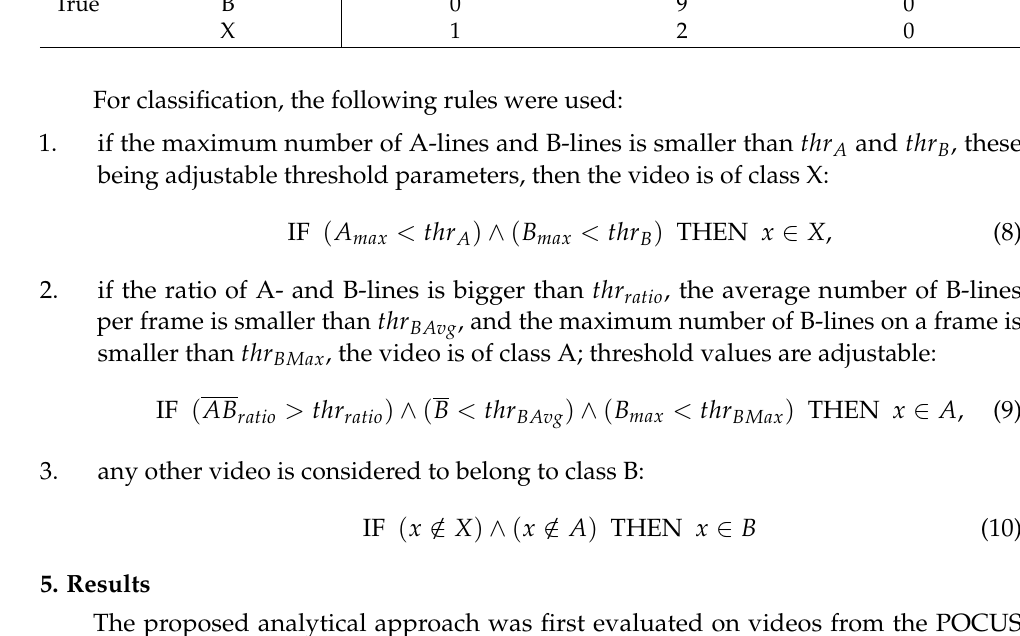
Table 3. Confusion matrix of video classification results. Class A represents videos showing A-lines, Class B represents videos showing B-lines, and Class X represents cases where classification is not possible and expert evaluation is required. Predicted A B